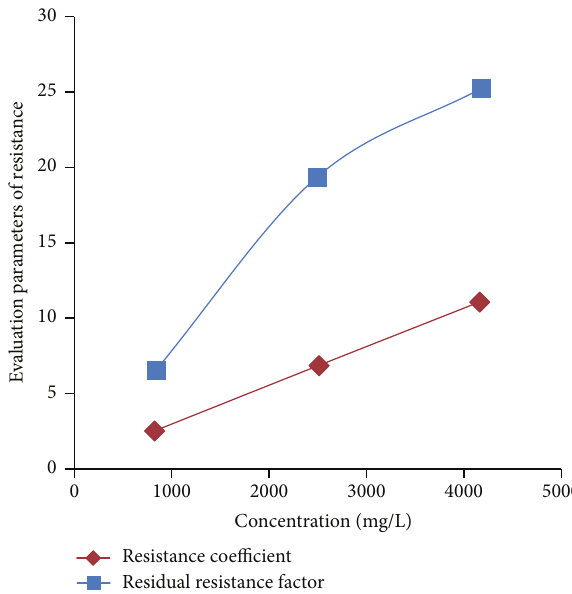
Figure 6: Relationship between resistance evaluation parameters and asphalt particles concentration (500